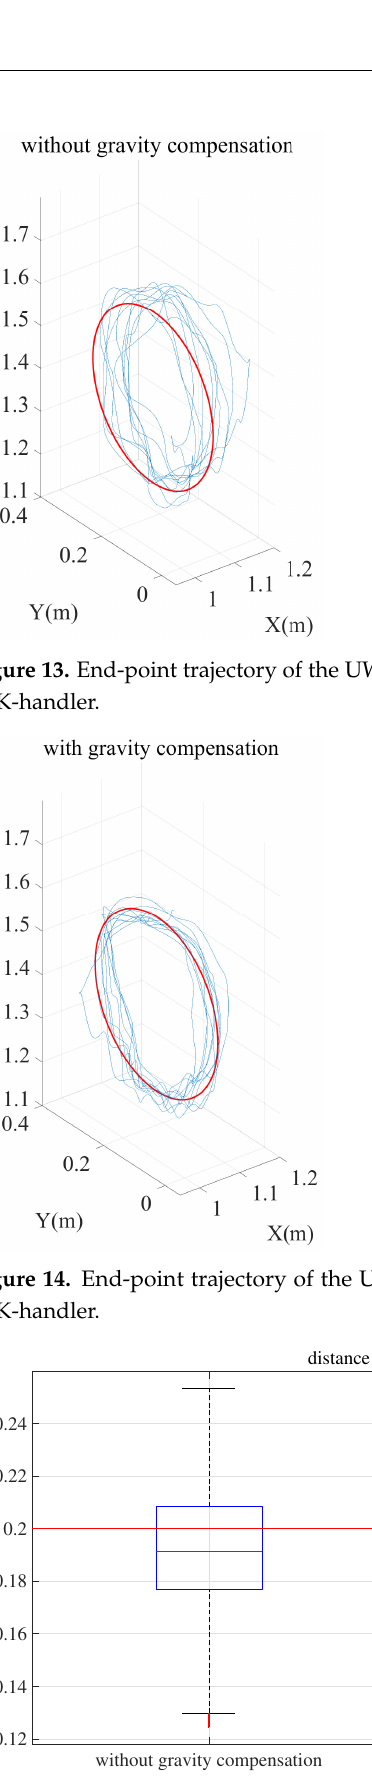
Figure 15. The mean and deviation for the distance from